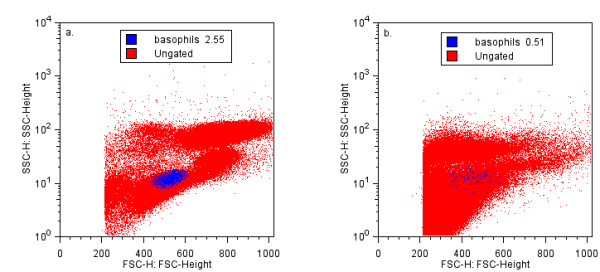
Backgated basophil populations. Backgated basophils identified after lysis with Immunoprep/Q-prep (a) and WBL (b).